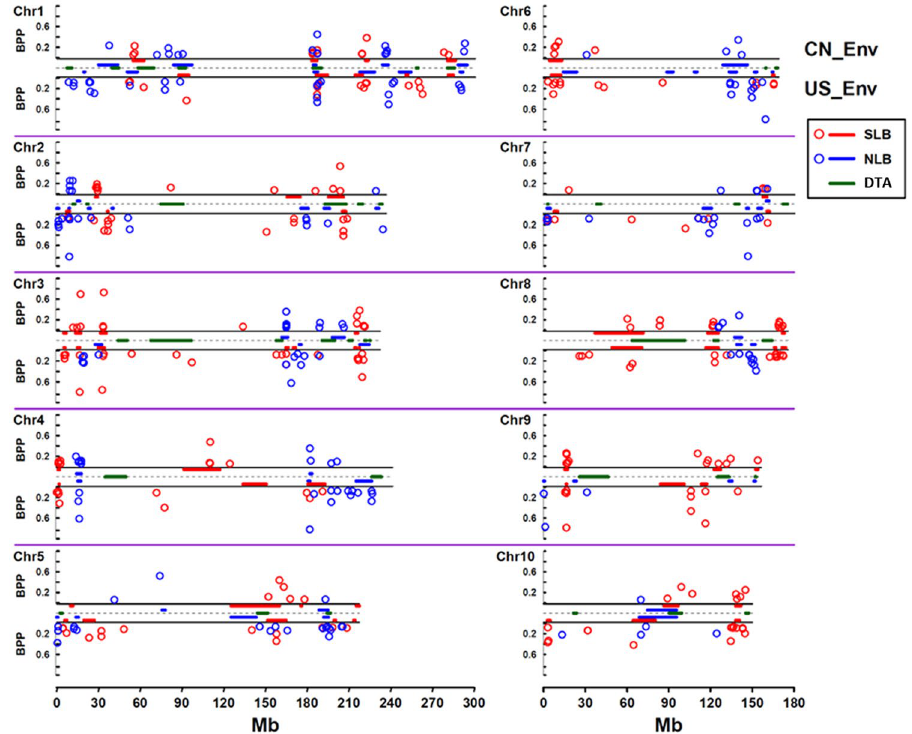
Figure 4. Overlap between QTLs and the identified associations. The linkage and association analyses were performed according to the different environments in the US (US_Env) and China (CN_Env). The strength of association is demonstrated as the bootstrap posterior probability (BPP). The locations of QTLs and associated loci are displayed for each chromosome, trait and panel. BPP is illustrated by the upper scale for the results in the environment of China and the lower scale for the results in the environment of the US. BPP is differentiated by colour for different traits (red for SLB and blue for NLB). QTL regions are indicated with solid lines (red for SLB and blue for NLB) at the top and bottom for the environments in China and the US, respectively. The QTL regions of DTA are indicated with green solid lines in the